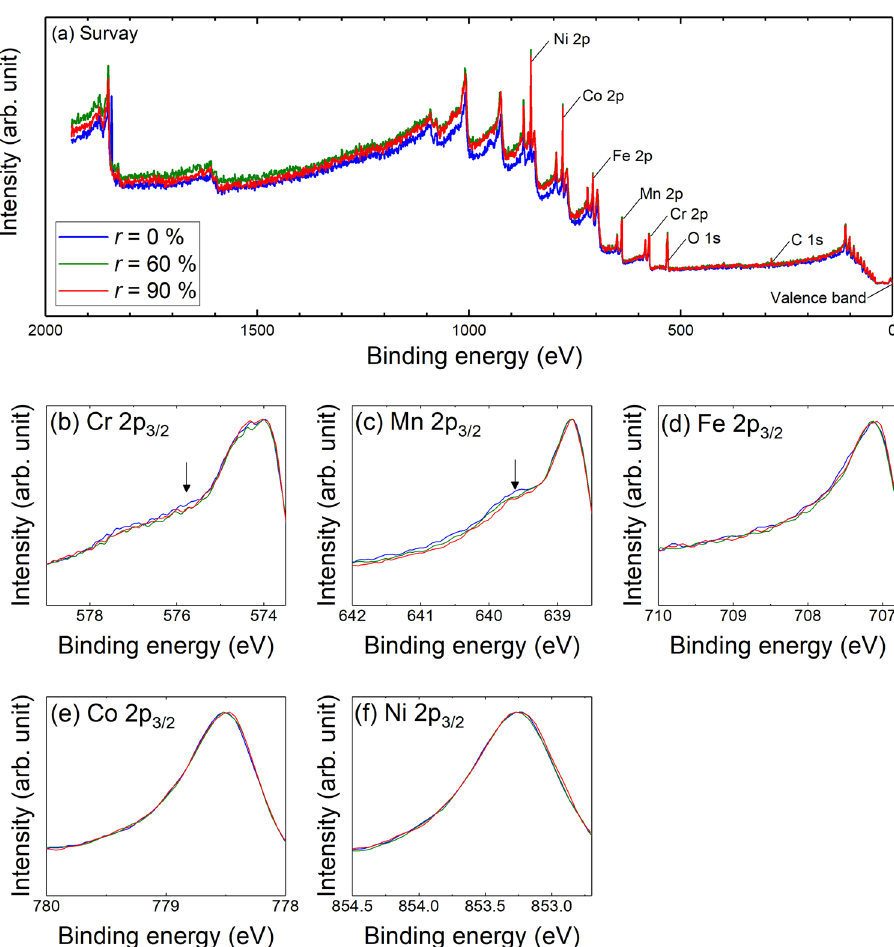
Figure 4. HAXPES spectra of ( a ) wide range survey with the bonding energy up to about 2000 eV, ( b ) Cr 2p 3/2 , ( c ) Mn